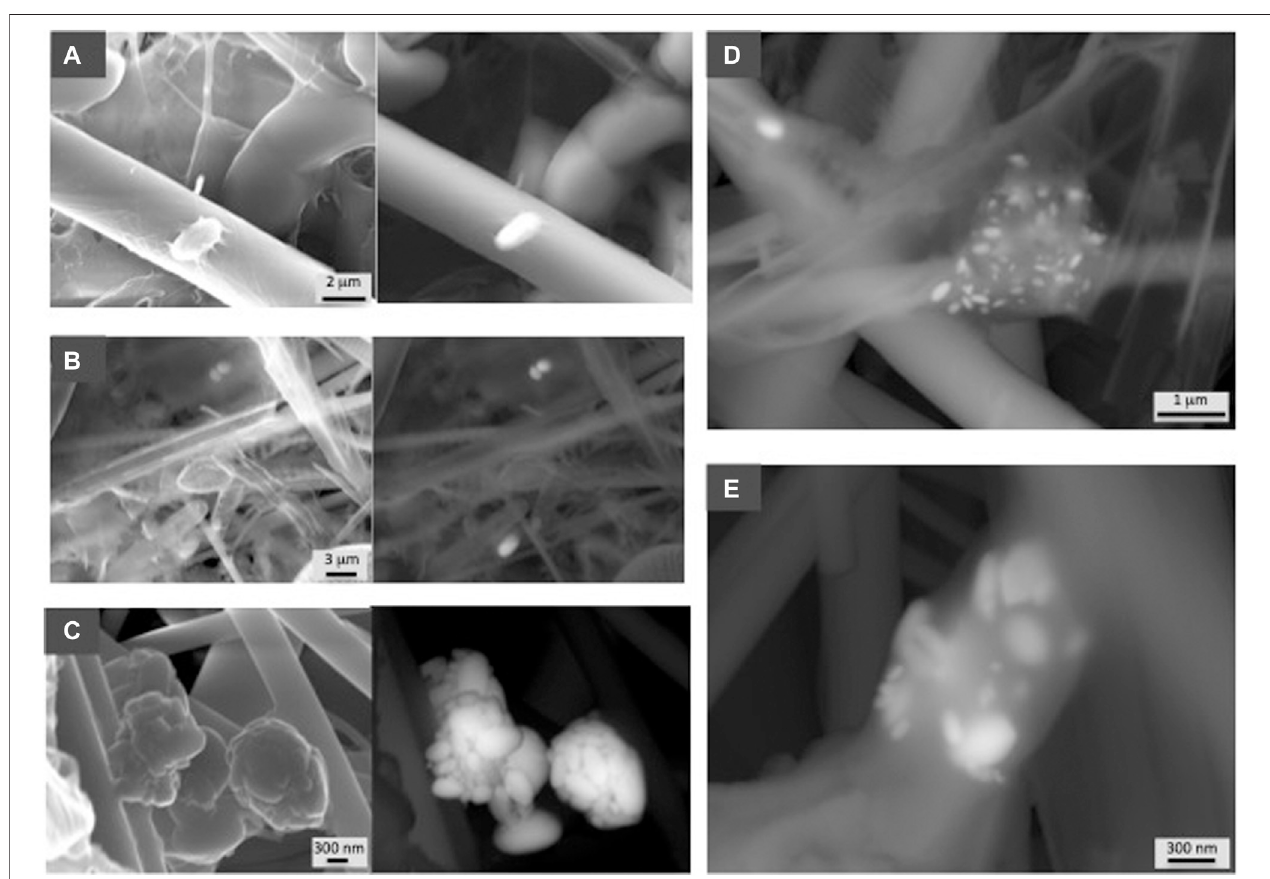
FIGURE 4 | SEM photographs showing representative examples of barite from the Indian sector of the Southern Ocean. Samples are indicated in Table 1 . Both secondary electron and in backscattered electron (BSE) mode at 30 kV are shown in each sample. (A) GCM 199 (20 m), (B) GCM 197 (125 m), (C) GCM 193 (500 m). (D) and (E) GCM 194 (300 m) show a detail of the different size of barite grains formed within organic aggregates.